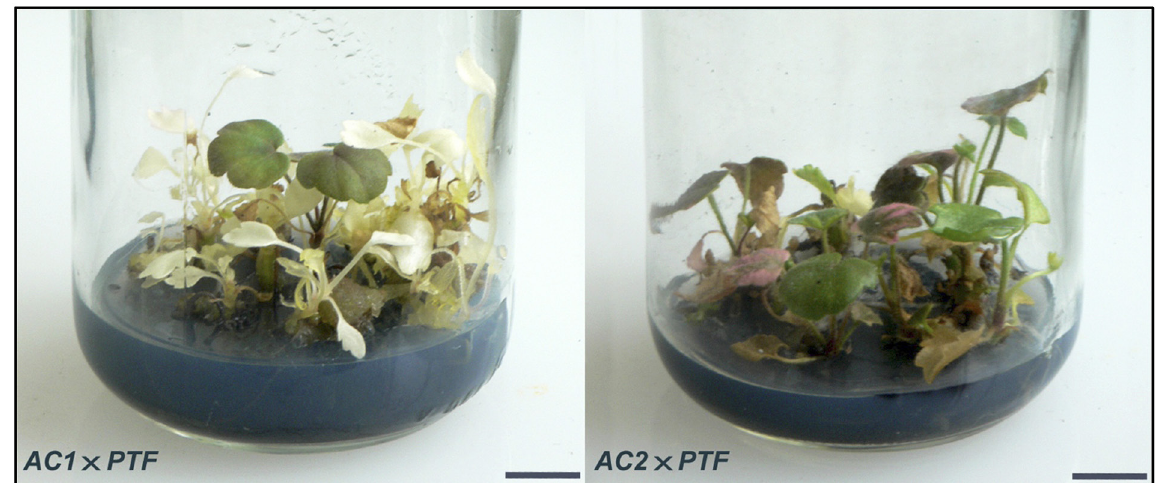
Fig. 4: Shoot regenerates from the interspecific combinations AC1 × PTF (left) and AC2 × PTF (right), cultured on AC-II-medium (six weeks after transfer). All regenerates within one jar (5.9 cm Ø ) originated from the same rescued embryo.